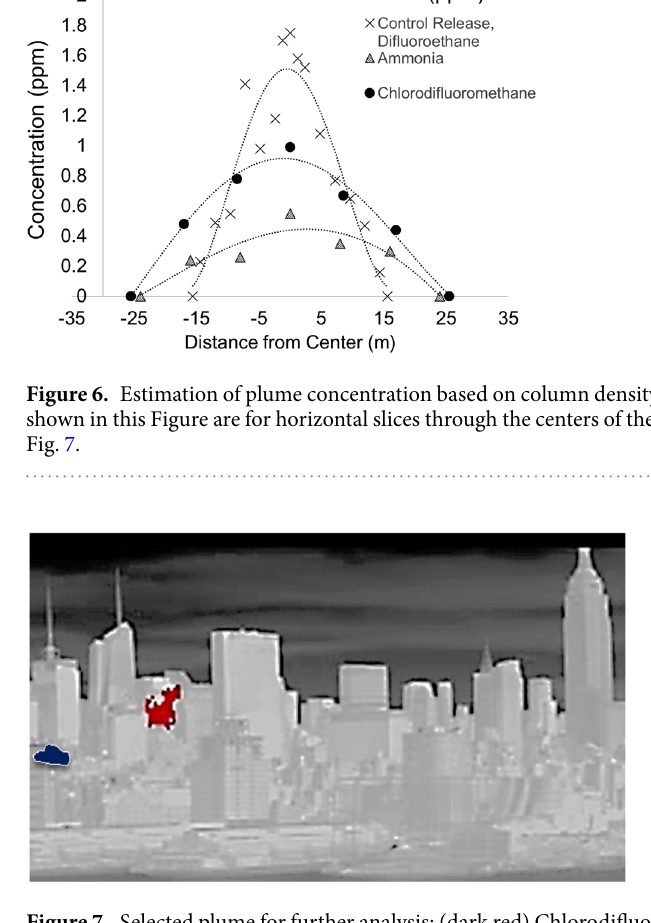
Figure 7. Selected plume for further analysis: (dark red) Chlorodifluoromethane, (dark blue) Ammonia. [Plumes obtained using HyperSEAL software (Aerospace Corp).